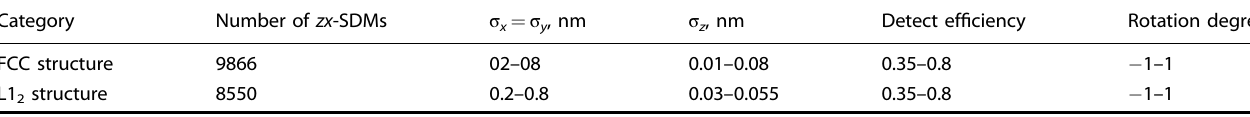
Table 1. Parameters for generating the crystal structure library and generating the corresponding zx -SDMs